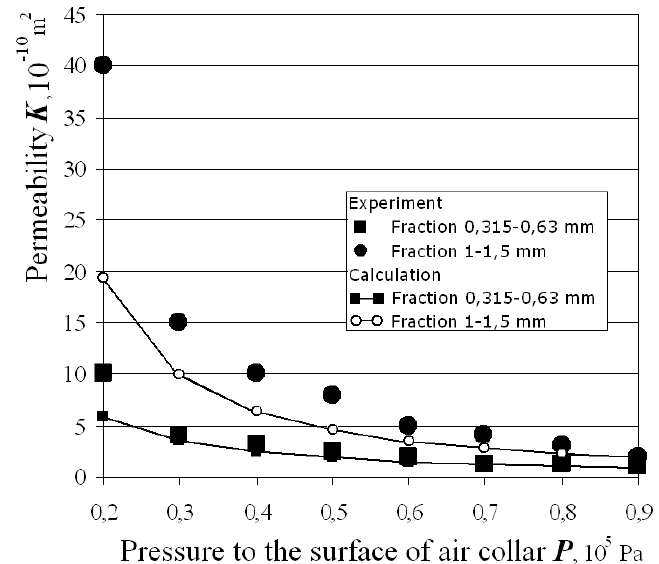
Figure 6. Permeability of replicated